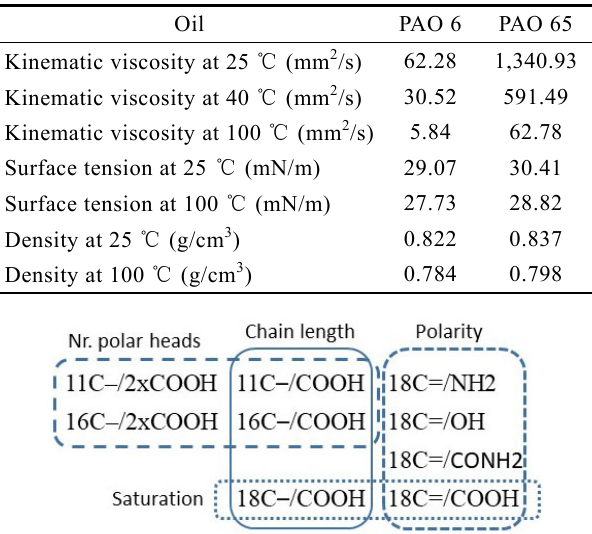
Fig. 1 Variation of nine additive molecules (undecanedioic, hexadecanedioic, undecanoic, palmitic, stearic and oleic acids, oley amine, oleyl alcohol, and oleylamide) indicating direct comparison of their